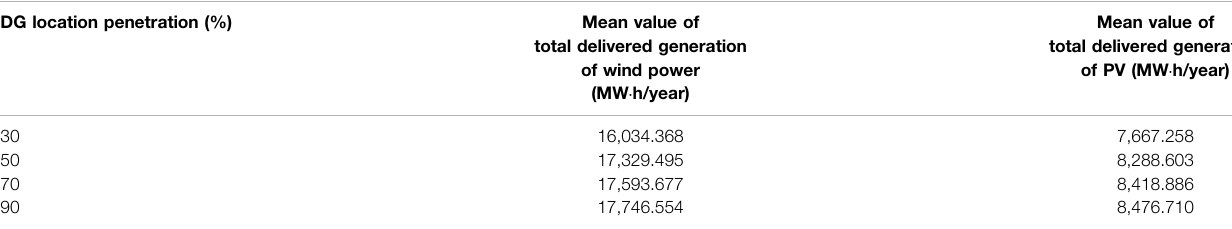
TABLE 4 | Statistical results of total delivered generation with different penetration